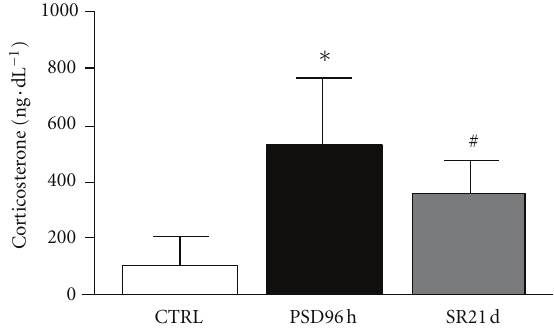
Figure 2: Mean ± SD concentration of plasma corticosterone (in ngdL − 1 ) of control group (CTRL), sleep deprivation (PSP), and sleep restriction (SR) at di ff erent time points. ∗ Di ff erent from all groups ( P < 0 . 01); # di ff erent from control group ( P < 0 . 01).